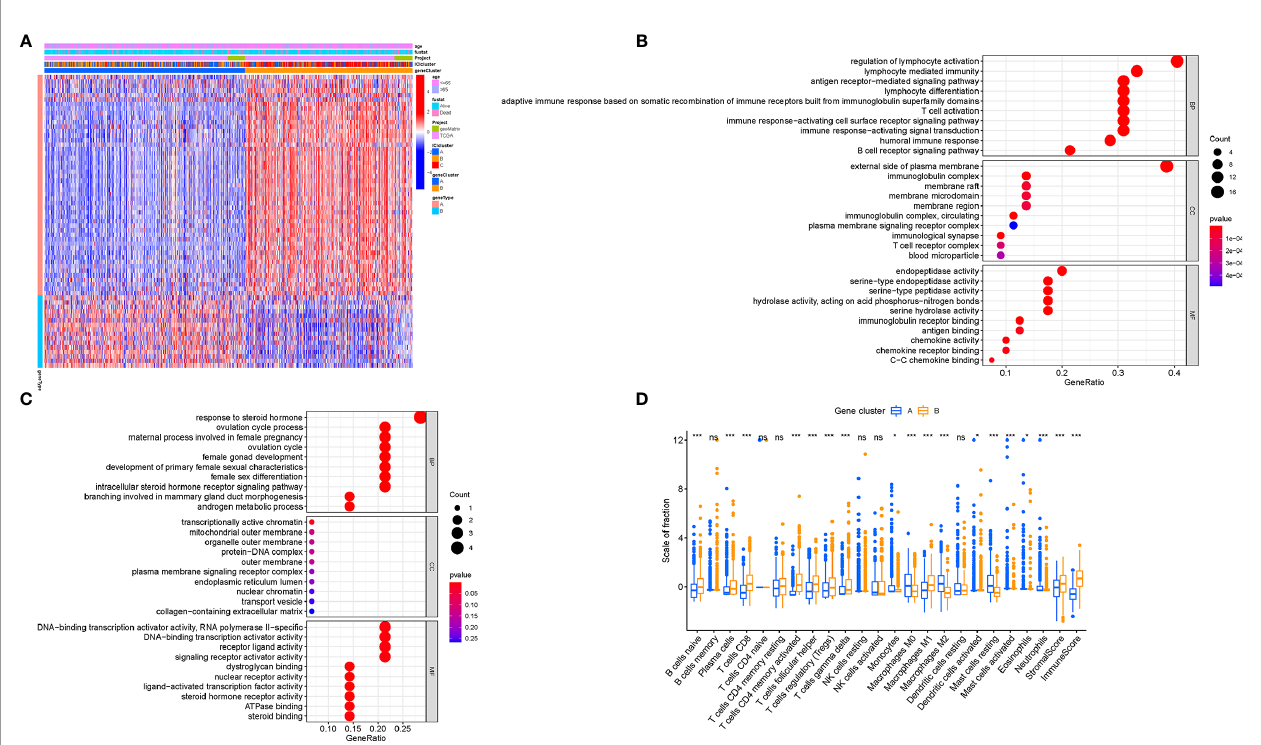
FIGURE 4 | Generation of Immunogenic Gene Subtypes. (A) Unsupervised clustering of common DEGs among three ICI cluster groups to categorize patients into two subgroups: gene clusters A – B. (B, C) Gene Ontology (GO) enrichment analysis of the two ICI-relevant signature genes: ICI signature genes A (B) and B (C) . (D) The proportion of in fi ltrating immune cells, stromal score, and immune score in two gene clusters. The asterisks represented the statistical p value (*P < 0.05; ***P < 0.001), ns, No Signi fi